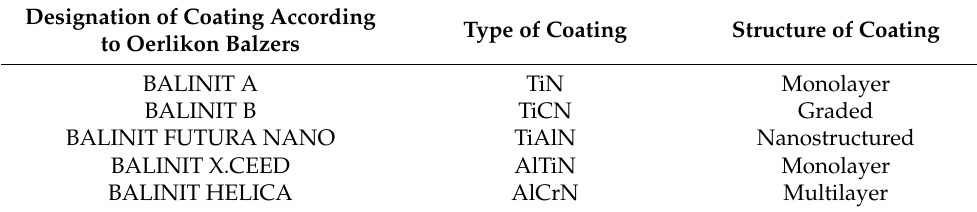
Table 1. Comparison of the protective coatings selected for testing.